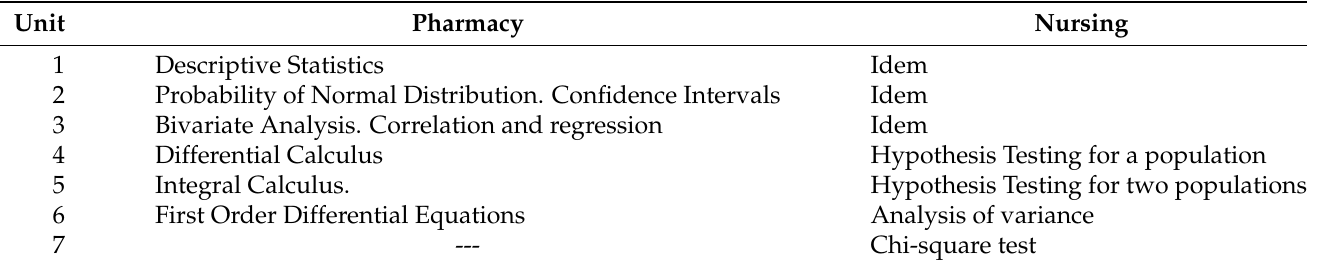
Table 5. Subject content.